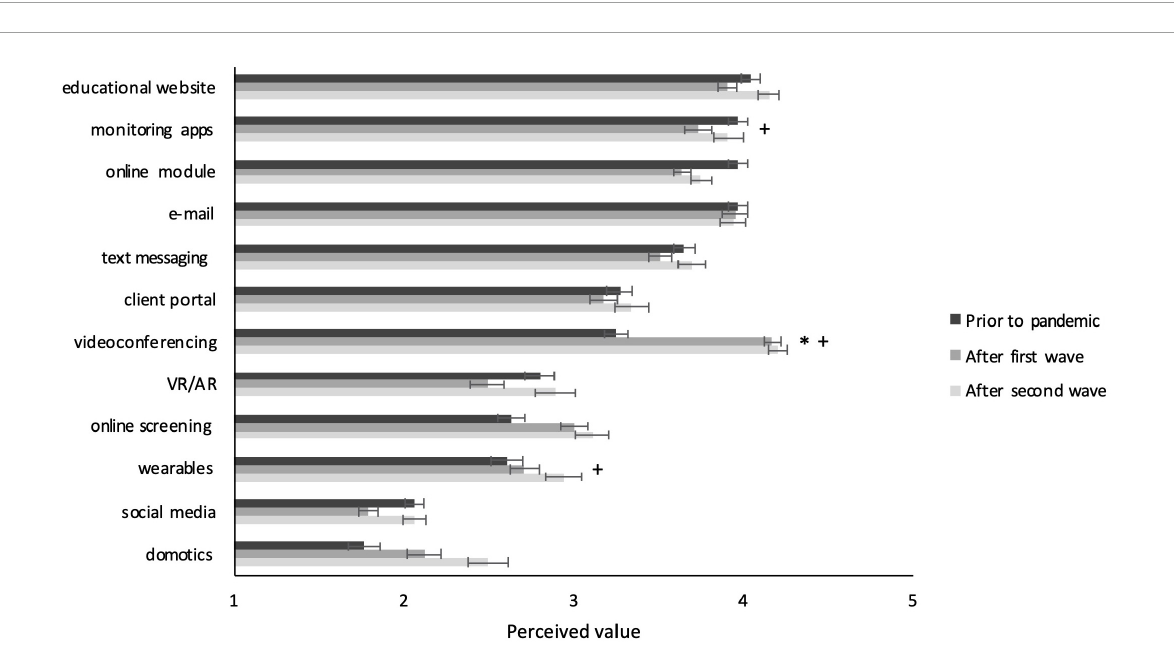
contained barriers regarding lack of skills, equipment, or an appropriate home environment of clients, or resistance to receive treatment through DMH. The factor